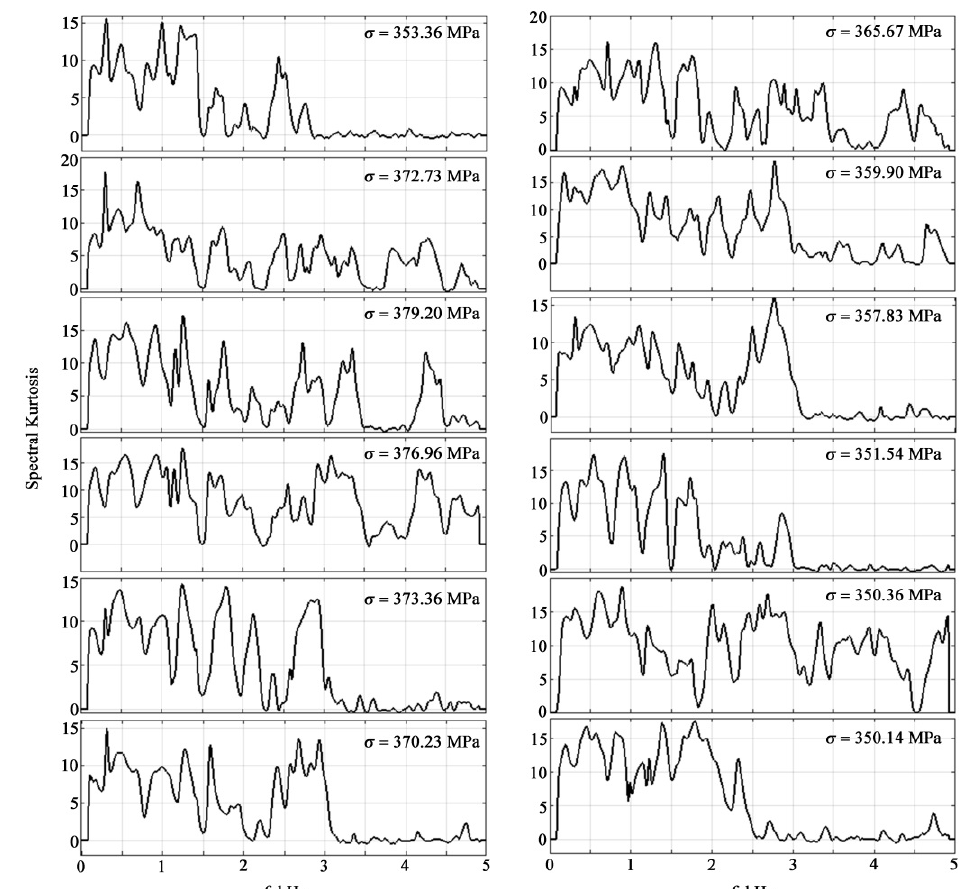
Figure 10. Spectral kurtosis of AE signals at different loads.